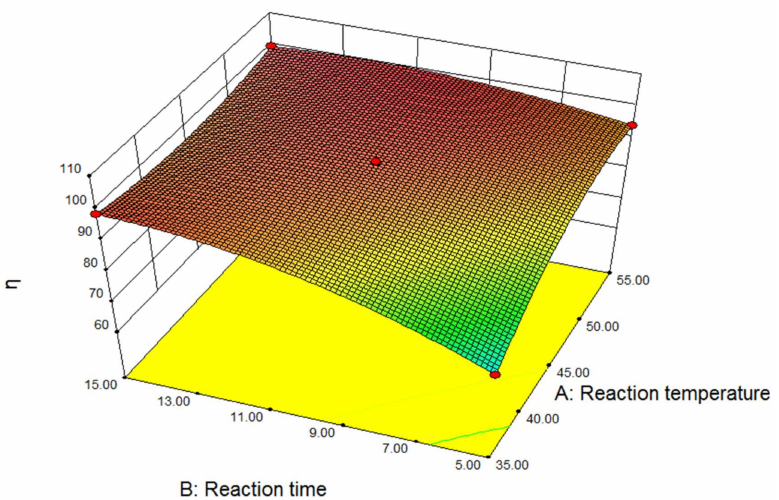
Figure 2. Influence of the reaction temperature and reaction time on the Cd removal